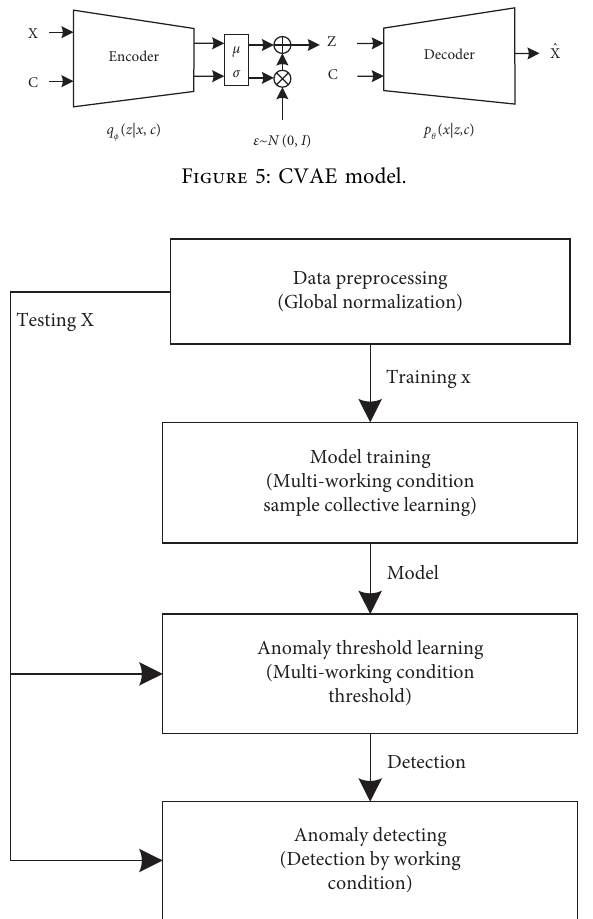
Figure 5: CVAE model.